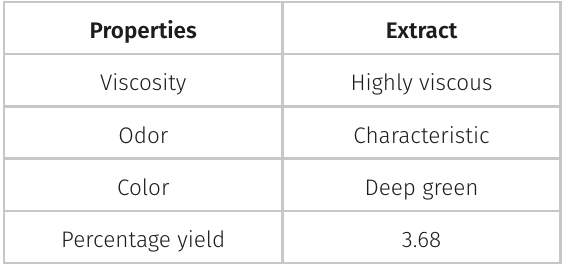
Table I. Physical properties and percentage yield of the S. hispanica seeds